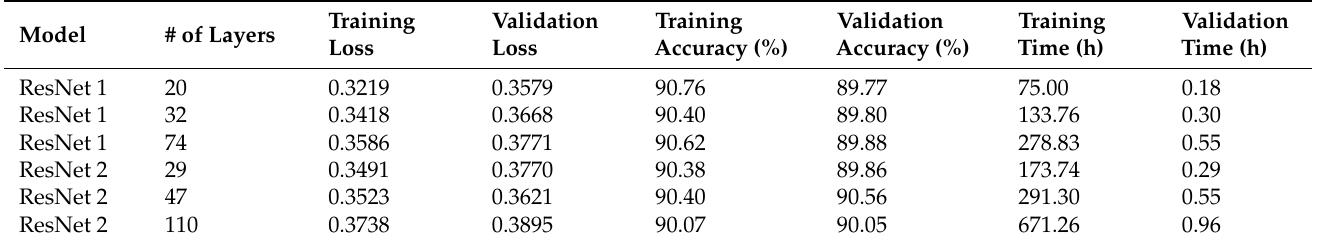
Table 4. Comparison of results using proposed minerals segmentation with different ResNet models and varying number of layers.